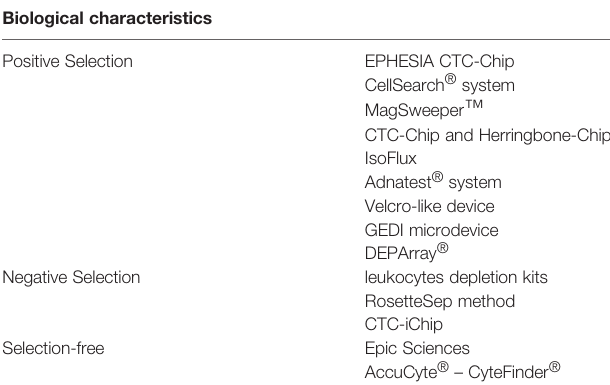
TABLE 2 | The strategies for isolation relied on biological features of